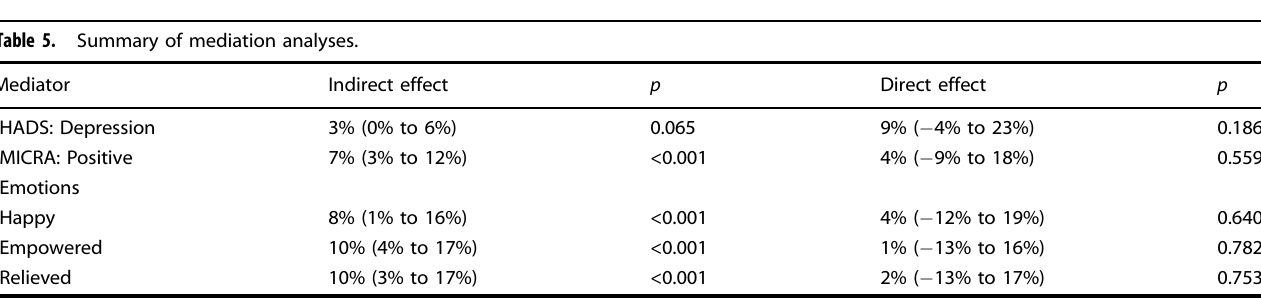
Table 5. Summary of mediation